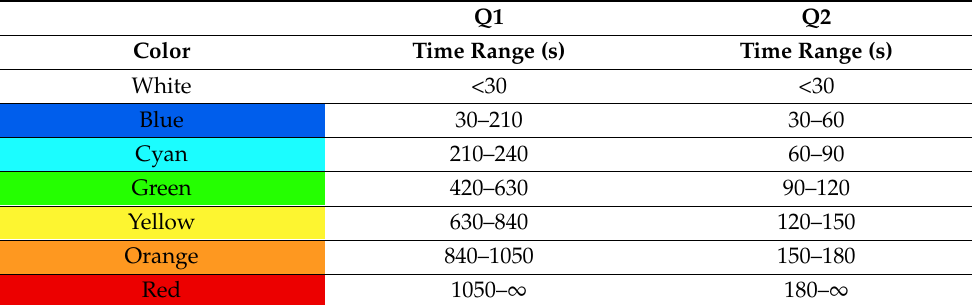
Figure 10. Schematic diagram of the partition analysis ( Q1 , Q2 ) Two areas with different time range settings for simulation). Table 2. The time range setting corresponding to colors.